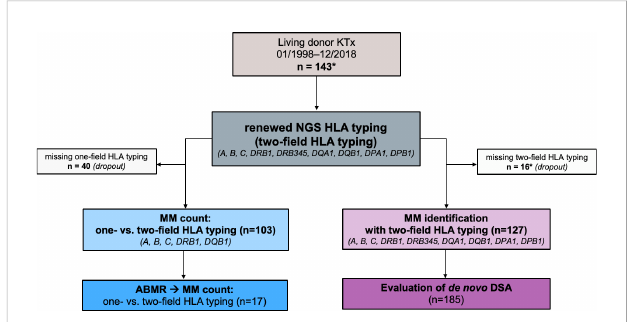
FIGURE 1 Study design. A total of 143 donor/recipient pairs who underwent living kidney transplant at the University of Leipzig Medical Center between 1998 and 2018 were enrolled for the study (*of note, one patient received two consecutive living kidney transplants - donors were the father and mother, respectively). The HLA typing data of 103 of these donor/recipient pairs were available in the registry at one- fi eld resolution (i.e., serological HLA typing or low-resolution genotyping). Based on these data, a mismatch count for HLA A, B, C, DRB1, DQB1 was generated and compared with one obtained from two- fi eld HLA typing (NGS HLA typing). For 127 of the donor/recipient pairs, we had in-center data from two- fi eld HLA typing for 11 HLA loci A, B, C, DRB1, DRB3, DRB4, DRB5, DQB1, DPA1, DPB1). Based on the results, we showed the frequency of allele-level HLA mismatches in our cohort and analyzed how often HLA antibodies can be classi fi ed as donor-speci fi c. ABMR, antibody mediated rejection; DSA, donor speci fi c antibodies; HLA, human leukocyte antigen; KTx, kidney transplantation; MM,